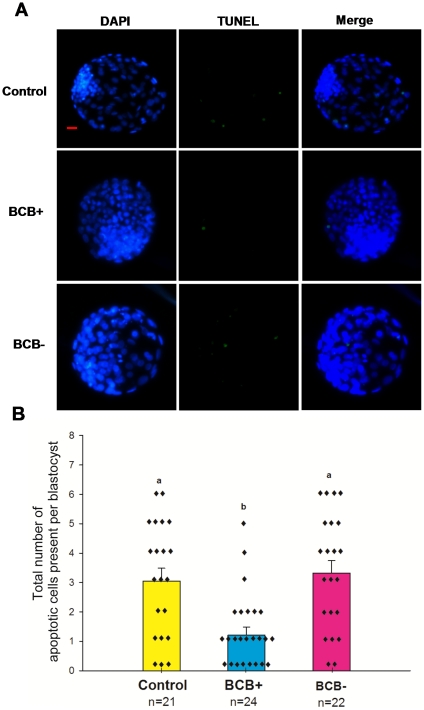
Incidence of apoptosis in blastocysts.(A) Representative photographs of TUNEL assay of blastocysts (green). Each sample was counterstained with DAPI to visualize DNA (blue). Original magnification was ×100. Bar = 20 µm. (B) Number of apoptotic cells in each blastocyst. Values with different superscripts differ significantly (P<0.05). n = 21, 24, and 22 in the control, BCB+, and BCB− groups, respectively.